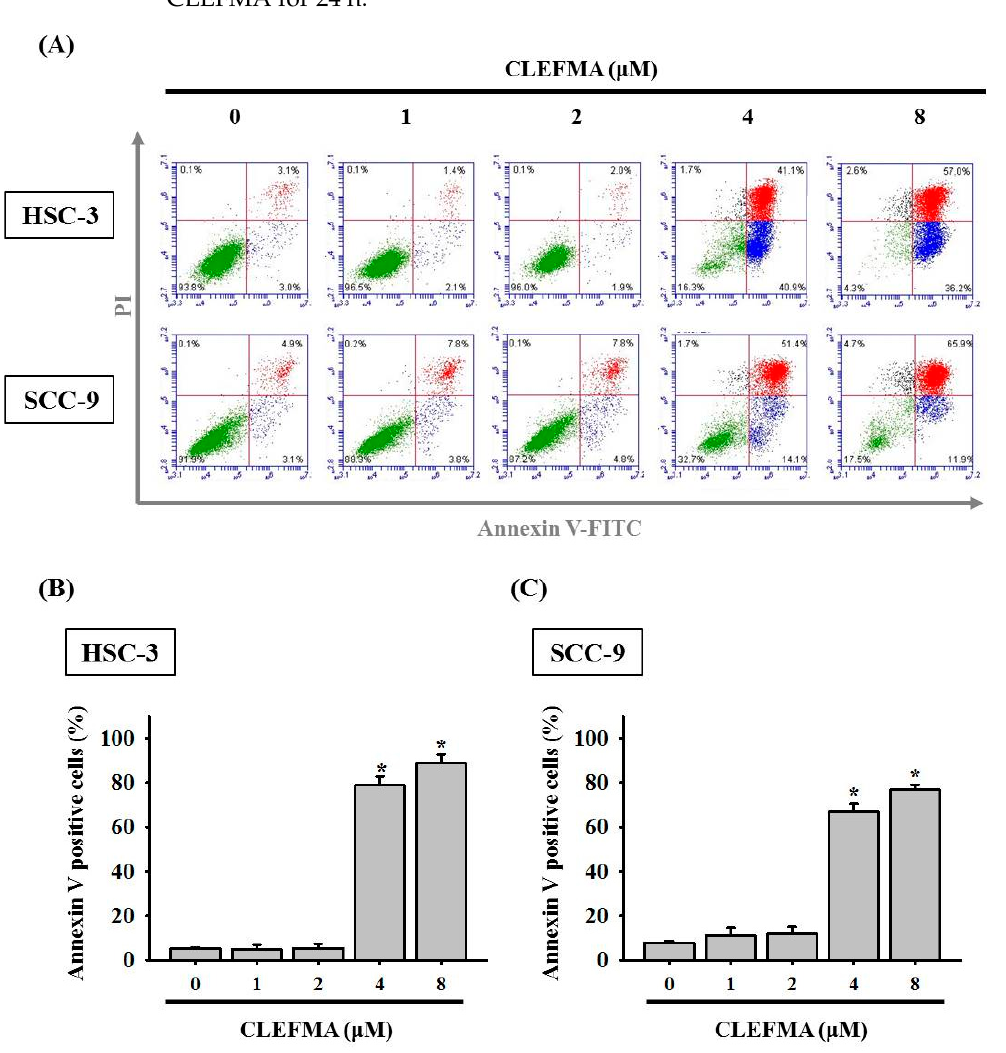
Figure 3. CLEFMA induced apoptosis in OSCC. ( A ) Cells were treated with various CLEFMA concentrations and then subjected to apoptosis assay through flow cytometry with annexin V/PI staining for 24 h. The quantification results of apoptosis assay of ( B ) HSC-3 and ( C ) SCC-9 cells are shown in the bar graph. Data represent the average ± standard deviation (SD) from three independent experiments. * p < 0.05 compared with the DMSO control group.